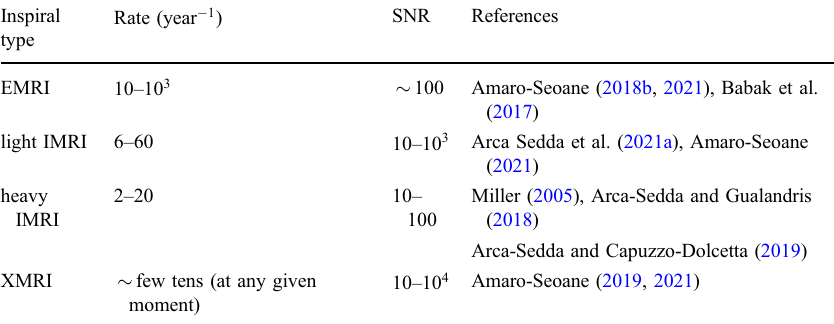
Table 9 Rates and SNRs for inspirals. Note that the rates for XMRIs are at any given moment in the MW and, possibly, nearby galaxies (see reference) Inspiral